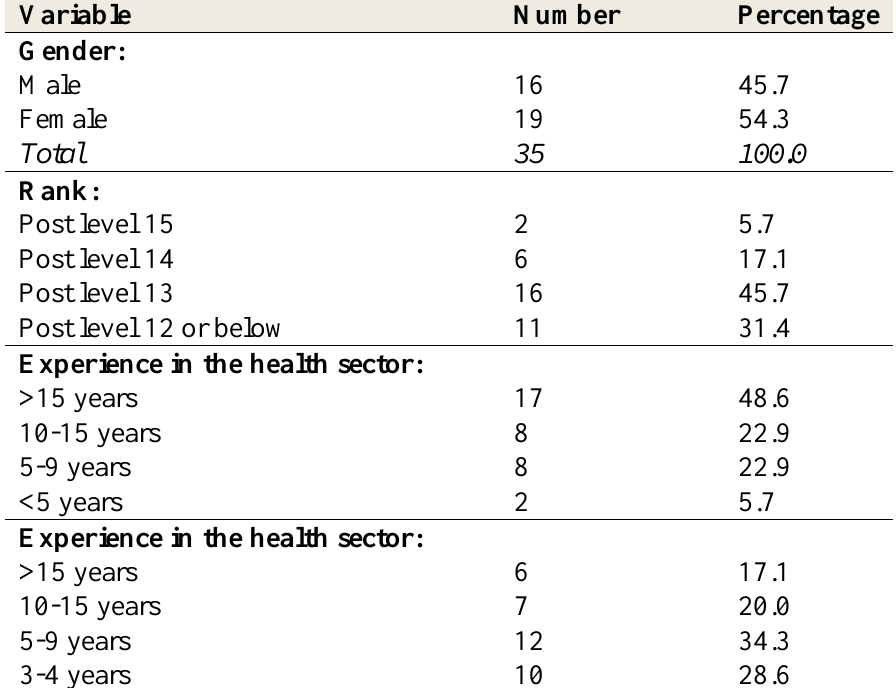
Table 1. Socio-demographic characteristics of study